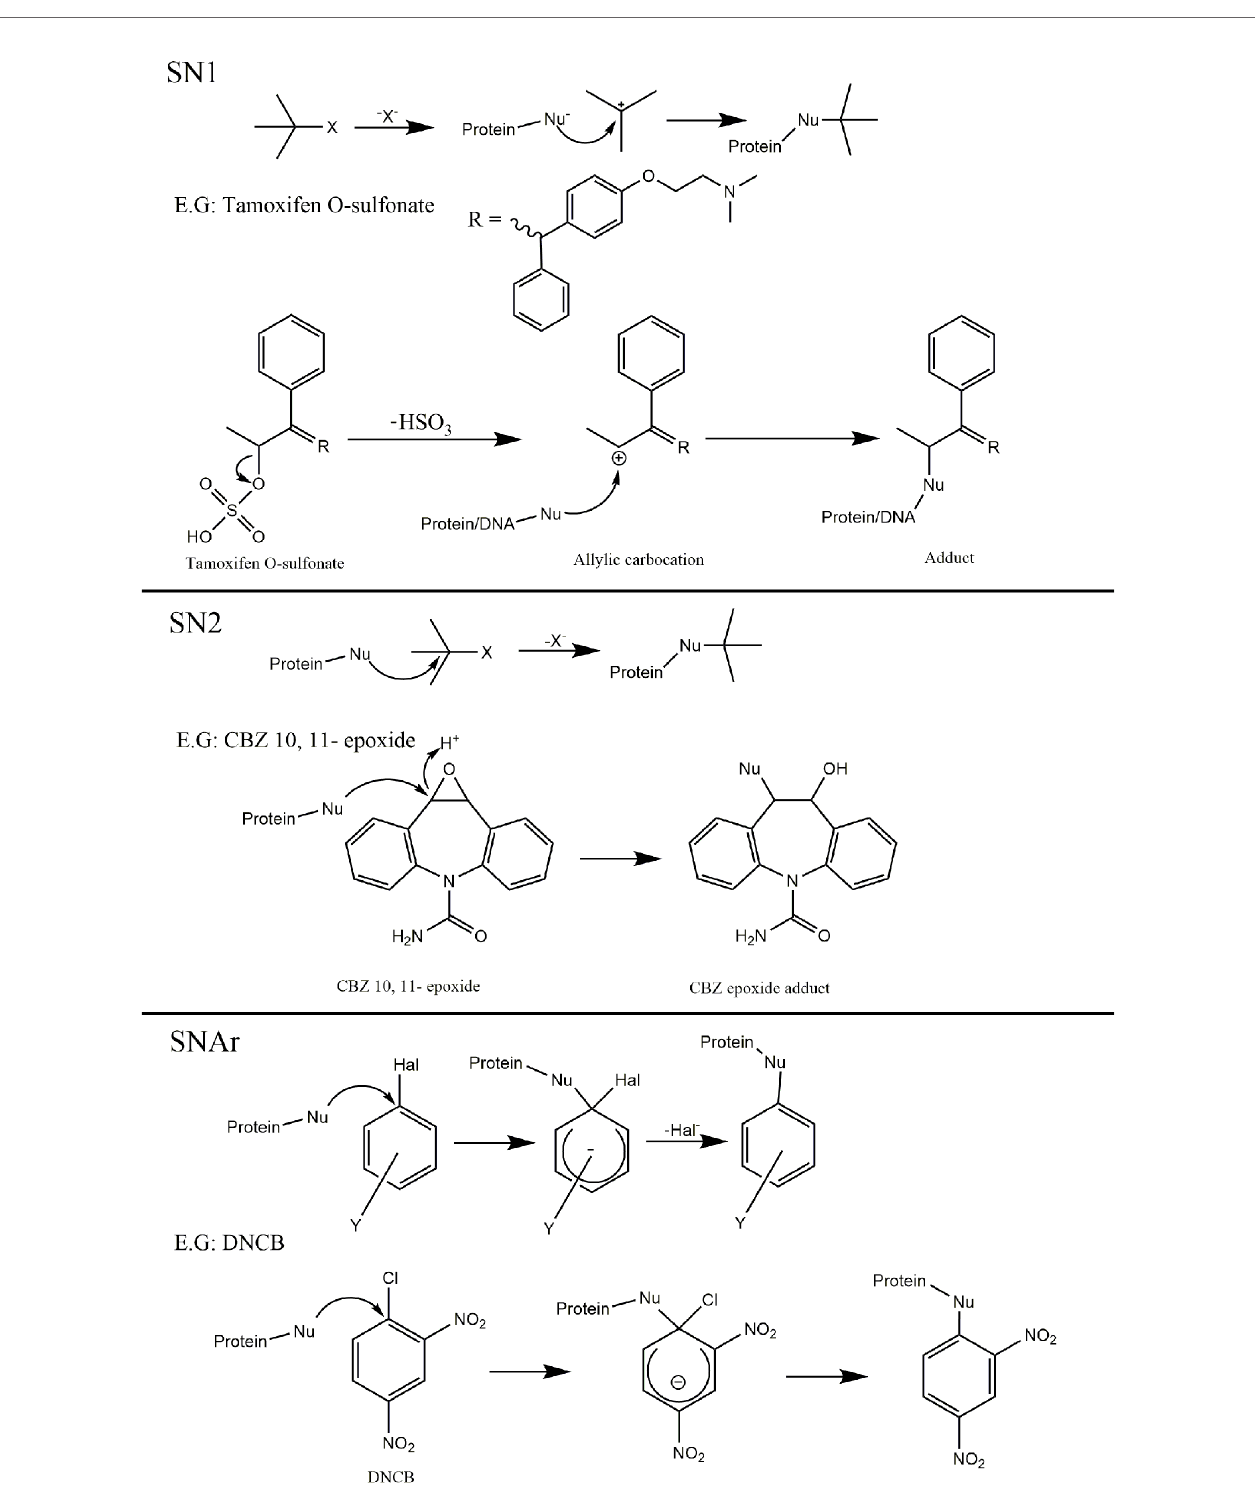
FIGURE 5 | Mechanisms of covalent binding. Outline of the 6 key mechanisms by which electrophiles react with biological nucleophiles with an example compound provided for each. SN1; Tamoxifen O-sulfonate metabolite (derived from sulfonation of a-hydroxytamoxifen) can collapse yielding an allylic carbocation reactive metabolite susceptible to nucleophilic attack, resulting in protein and adducts (111 – 114). SN2; Carbamazepine (CBZ) 10, 11 - epoxide (reactive metabolites derived from carbamazepine) (115). SNAr; Dinitrochlorobenzene